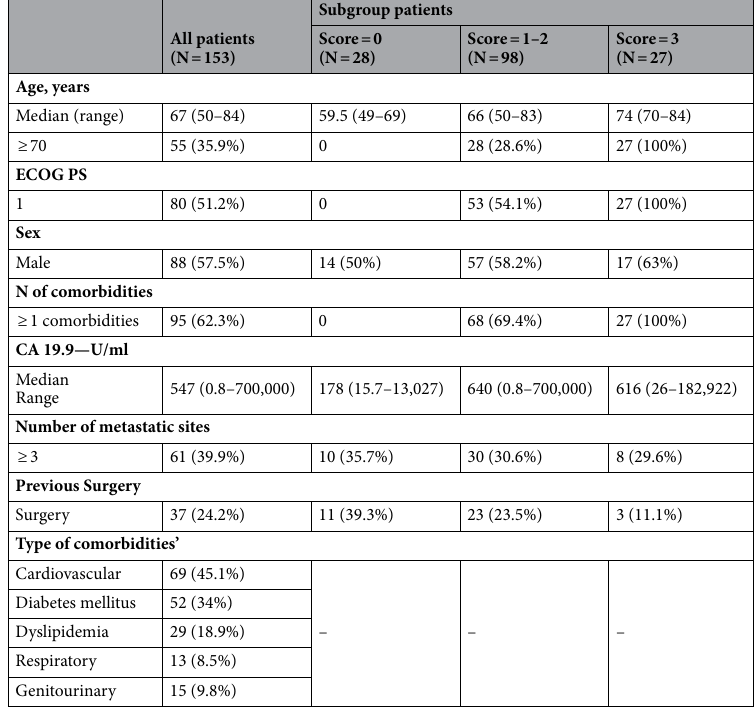
Table 1. Patient characteristics. Number (N); Eastern Cooperative Oncology Group Performace Status (ECOG PS); carbohydrate antigen 19.9 (CA